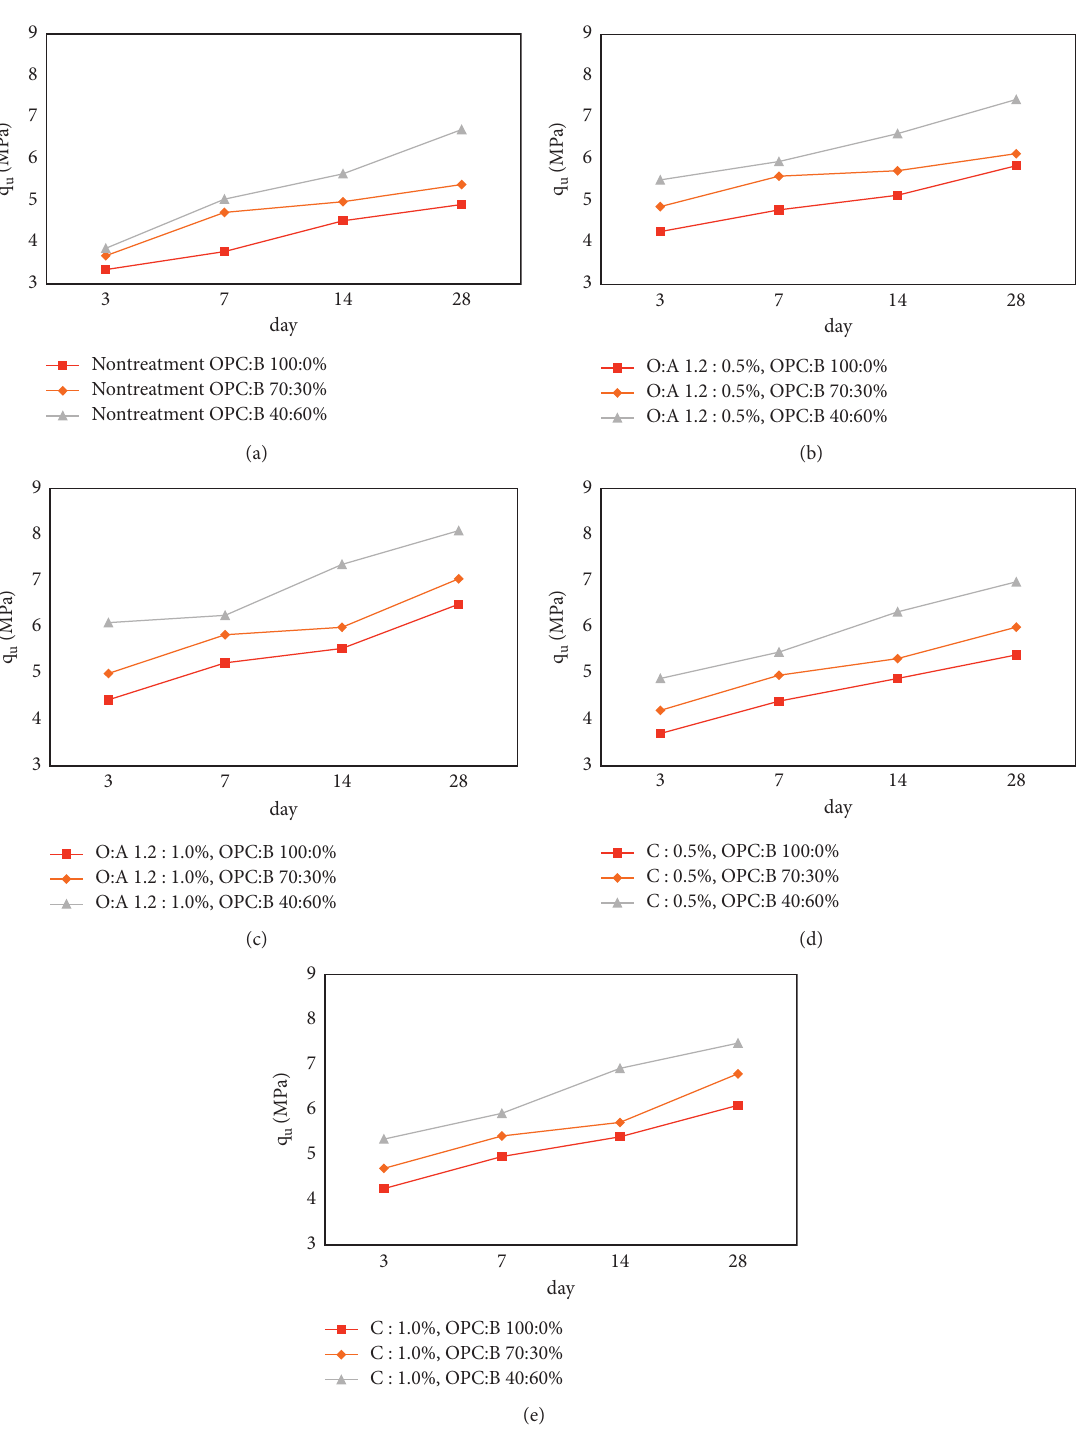
Figure 5: Analysis of uniaxial compressive strength by C : B mixing ratios: (a) results of uniaxial compression test from nontreated specimen; (b) results of uniaxial compression test for O : A � 1.2: 0.5%; (c) results of uniaxial compression test for O : A � 1.2 :1.0%; (d) results of uniaxial compression test for C � 0.5%; (e) results of uniaxial compression test for C �